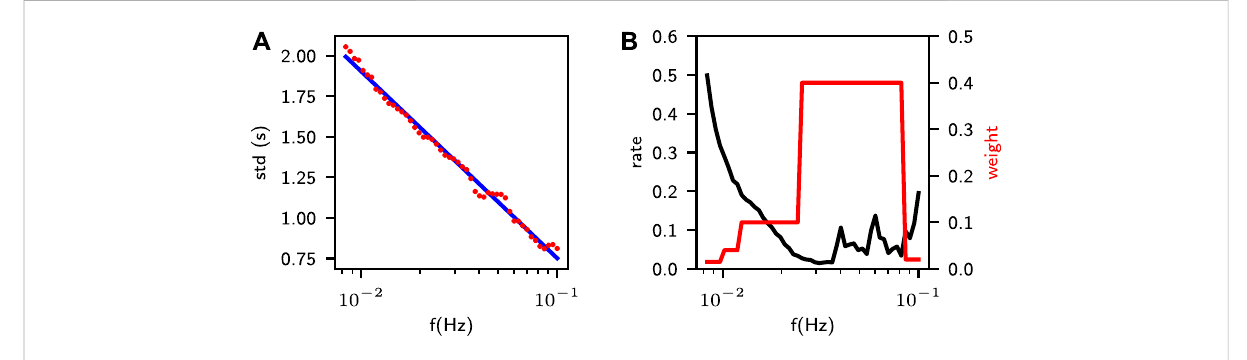
FIGURE 3 (A) The standard deviation (red dots) of single-pick errors at target frequencies and the logarithmic function for approximation (blue line). (B) The rate of dropped picks of the observational data at target frequencies (black line) and the corresponding weights for corresponding dropped channels (red